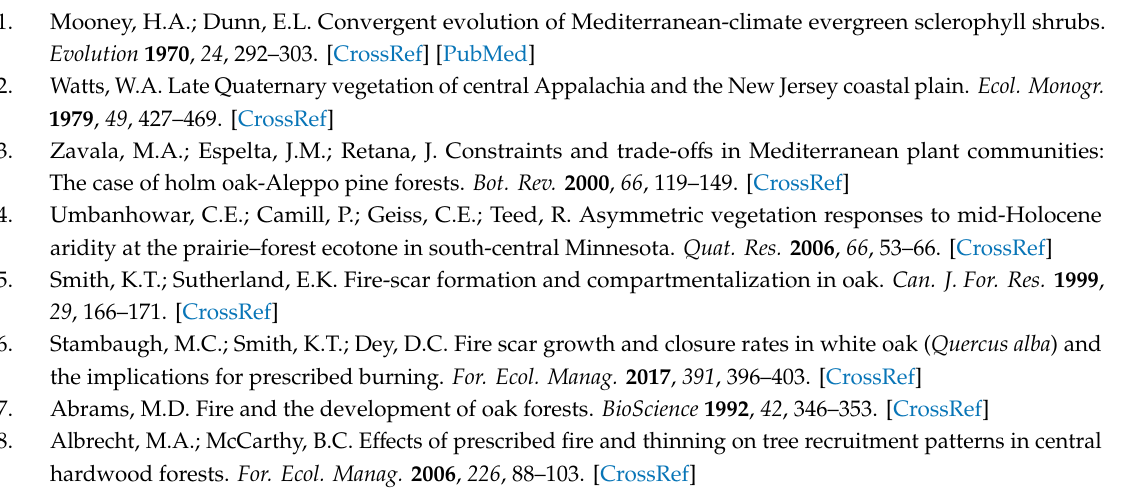
Figure S1: Three paneled-figure showing change in Kr, MVA, and vessel number as a function of age in both a linear (left) and exponential (right) fit. Fitting an exponential curve on this relationship explained more variance for Kr and MVA, while a linear fit explained slightly more variance for vessel number. The above curves were used to determine which type of age detrending was to be applied to the raw values of Kh, MVA, and number of vessels for the 11 year time-series for each disc. Figure S2: Three paneled-figure showing heatmaps and associated tables for monthly climate correlation coe ffi cients and their associated p values (derived from bootstrapping, only the top 15 correlations) for potential hydraulic conductivity Kr (top), mean vessel area MVA, and vessel number (bottom). Max Temp (tmax), precipitation sum for each month in cm (ppt), and maximum daily vapor pressure average for each month (VpdMax) for each month within the 24 month period were correlated with the age-detrended “transect” values for Kr, MVA, and vessel number. Heatmaps only show through the current Sep, since we did not consider the correlations after this monthly period, though these correlation coe ffi cients may still be found in the accompanying table if the relationship is one of the top 15